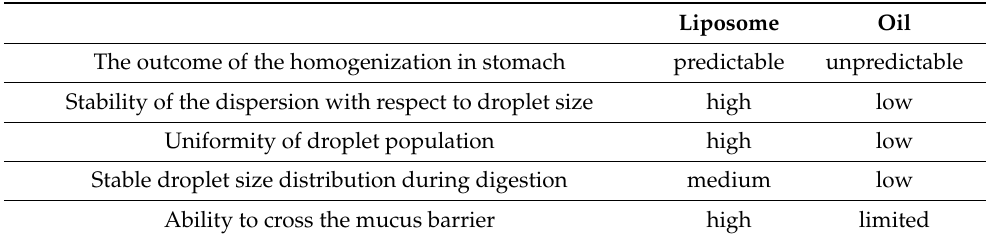
Table 1. Properties of liposomal and oily vitamin D 3 formulations relevant for the absorption in the intestine [15,18,19,27,35–37]. Liposome Oil The outcome of the homogenization in stomach predictable unpredictable Stability of the dispersion with respect to droplet size high low Uniformity of droplet population high low Stable droplet size distribution during digestion medium low Ability to cross the mucus barrier high